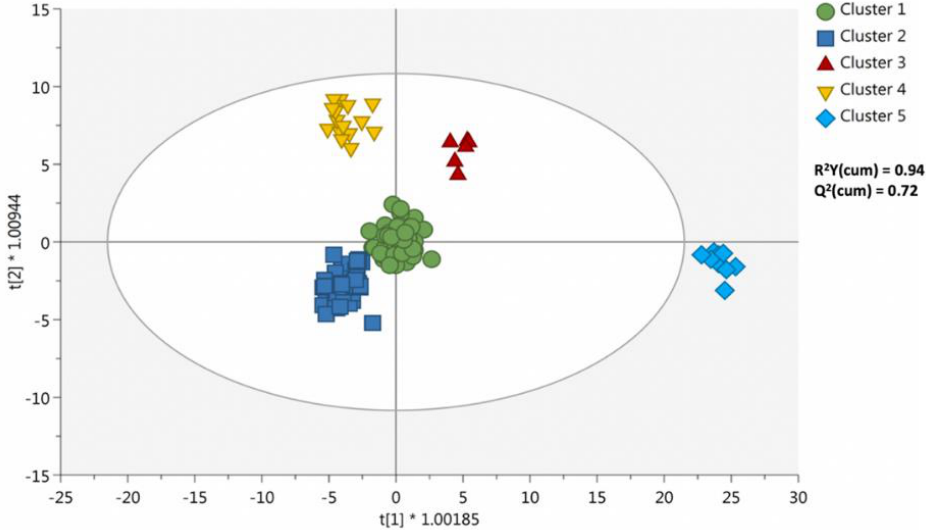
Figure 3. Orthogonal projection to latent structures (OPLS) discriminant analysis (DA) considering the cluster-type as class discrimination parameter.